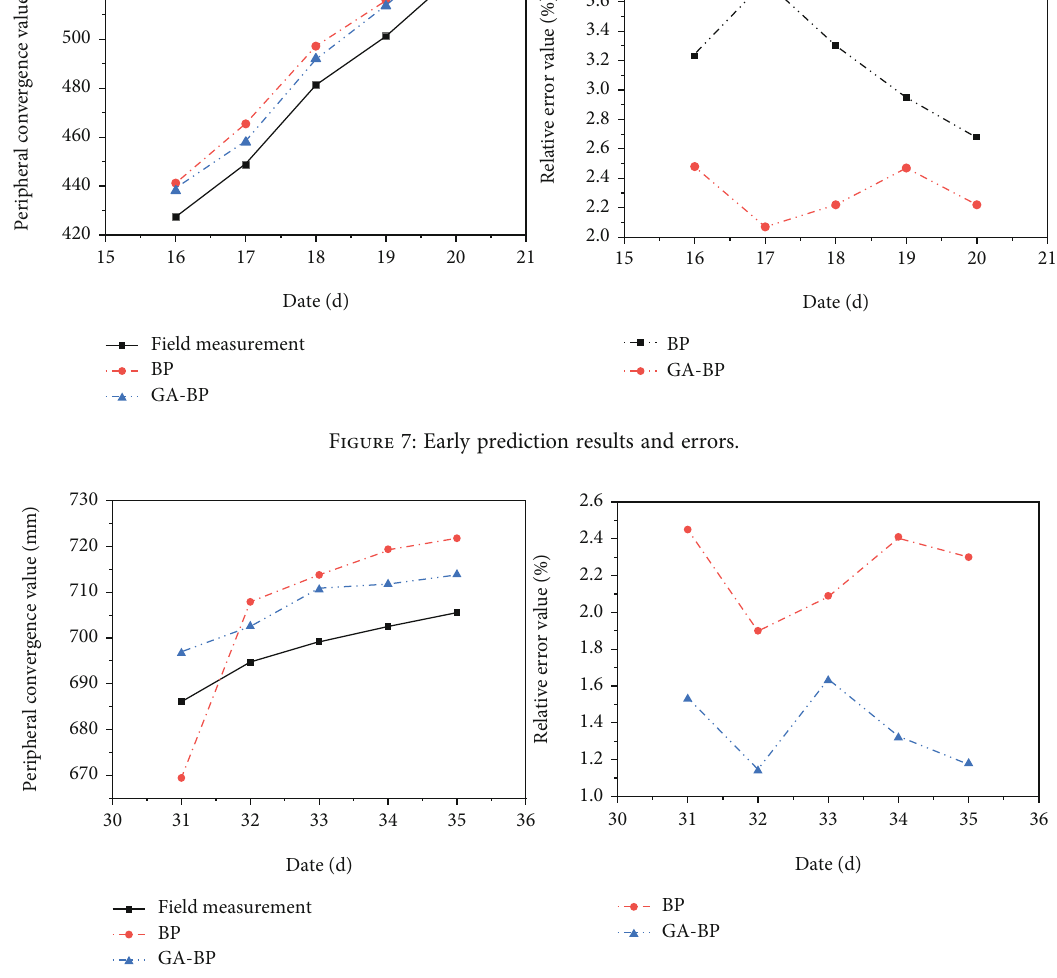
Figure 8: Medium term forecast results and errors.